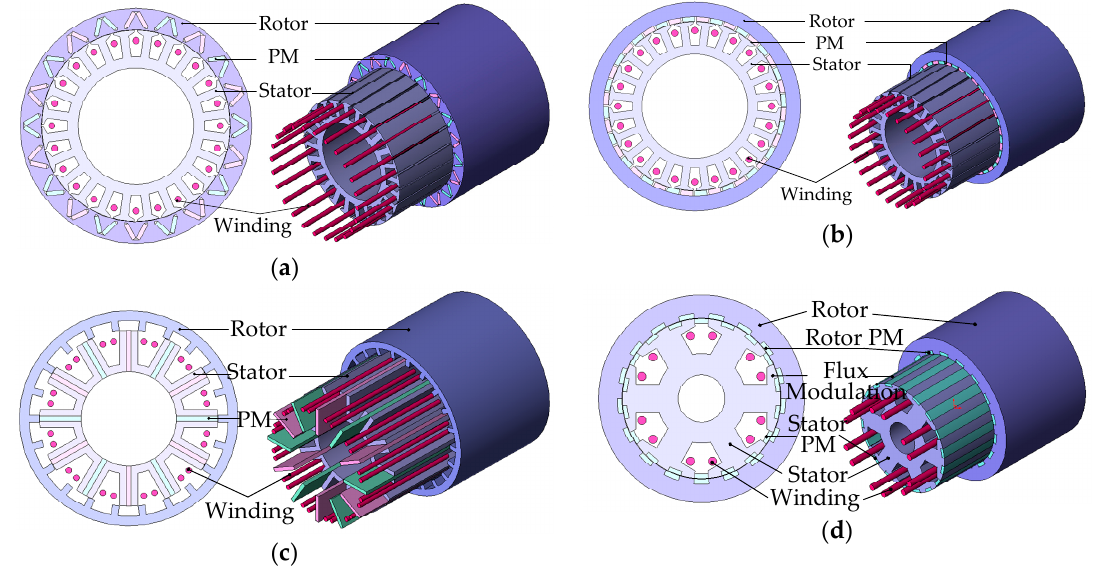
Figure 1. Proposed six-phase outer-rotor machine topologies: ( a ) IPM type; ( b ) SPM type; ( c ) PMFS type; ( d ) PMV type.